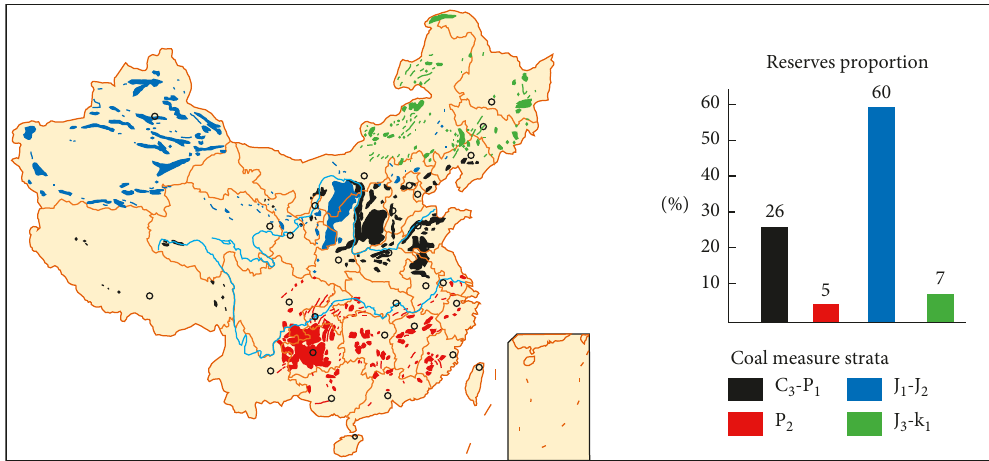
Figure 2: Distribution diagram of the major coal resources in